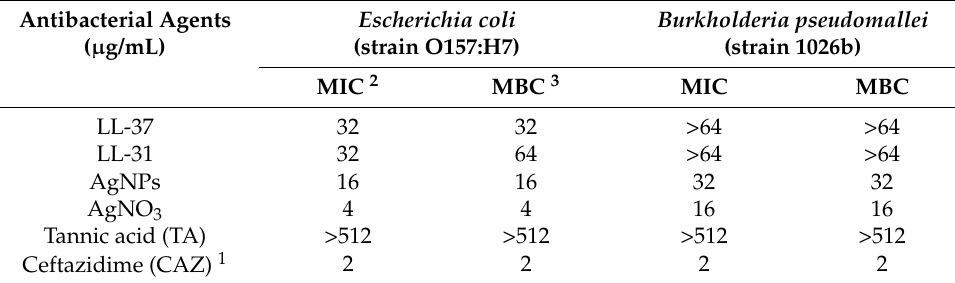
Table 1. Minimum inhibitory concentration (MIC) and minimum bactericidal concentration (MBC) of antibacterial agents against E. coli (O157:H7) and B. pseudomallei (1026b) after 20 h incubation at 37 °C, performed with the microdilution method and colony plate counting assay. Antibacterial Agents (µg/mL)